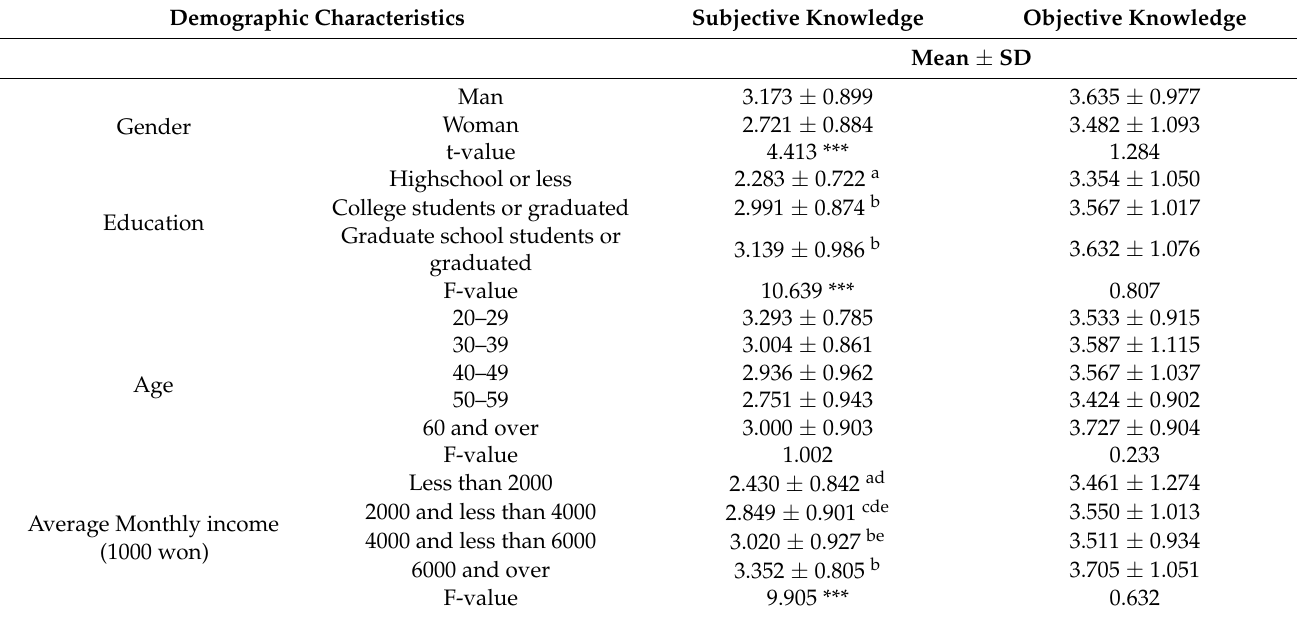
Table 3. Comparisons of knowledge among demographic